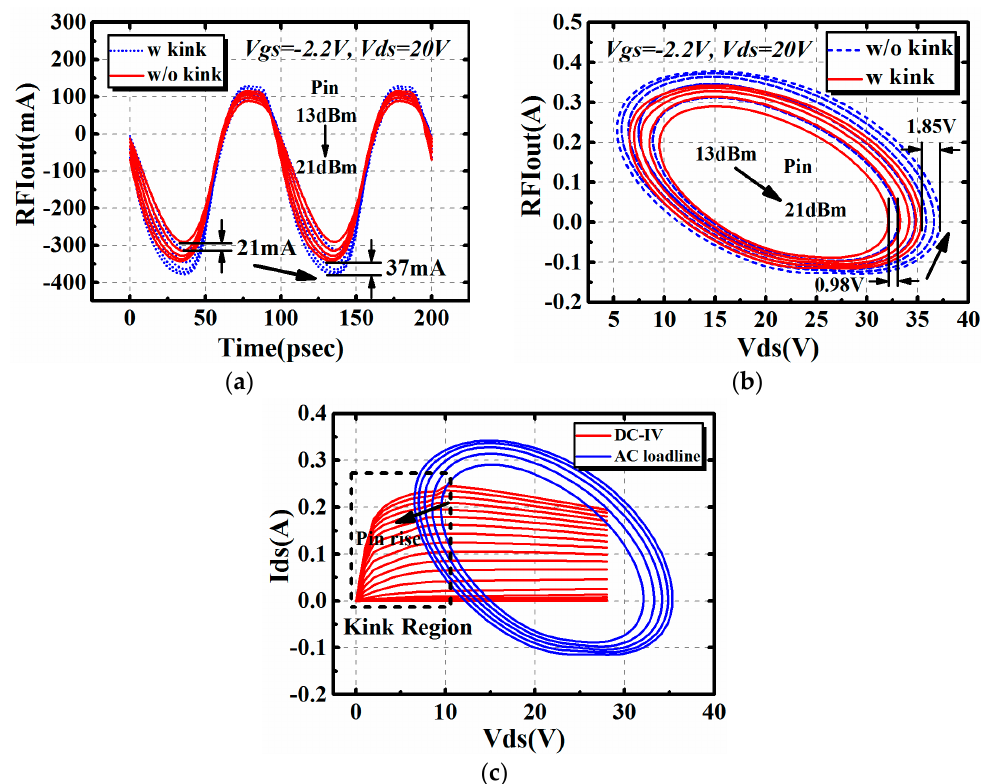
Figure 9. Investigation on influence brought by the I–V kink effect on time domain characteristics with different input power @10 GHz: ( a ) time domain waveform, ( b ) AC dynamic load line and ( c ) DCIV and AC dynamic load line.